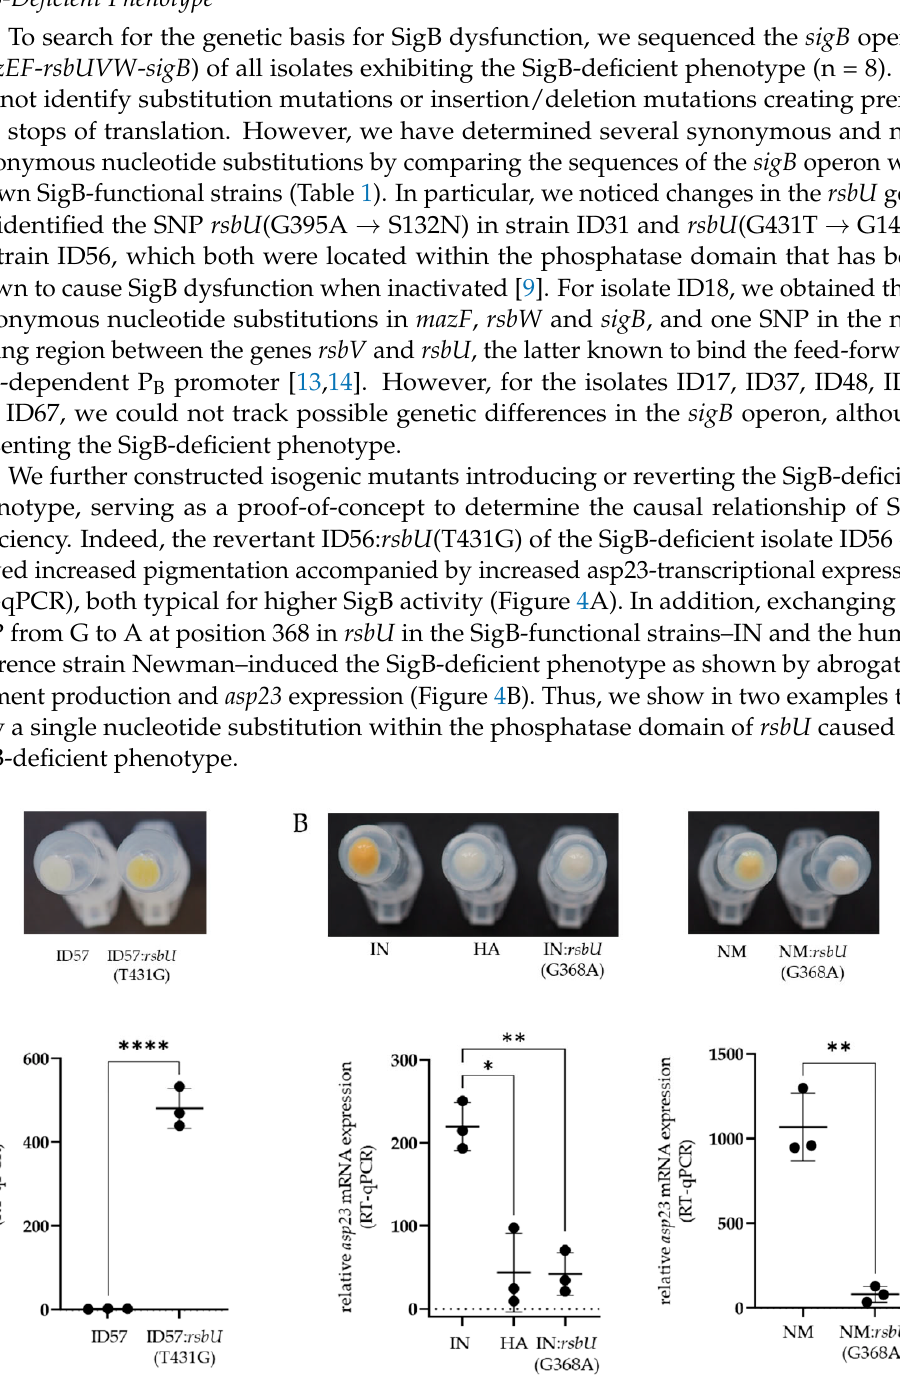
Figure 4. Proof of the causal relationship of SigB deficiency based on a single nucleotide mutation in rsbU. Changes in bacterial surface pigmentation and asp23 -mRNA expression (RT-qPCR) were shown, which are indicators of SigB activity. ( A ) Restoring the SigB-functional phenotype by exchanging the single nucleotide rsbU (T431G) in the SigB-deficient bovine mastitis isolate ID57. ( B ) Induction of the SigB-deficient phenotype by exchanging the single nucleotide rsbU (G368A) in the SigB-functional initial (IN) bovine mastitis isolate and the SigB-functional human reference strain Newman (NM); (* p < 0.05, ** p < 0.01, *** p < 0.001).